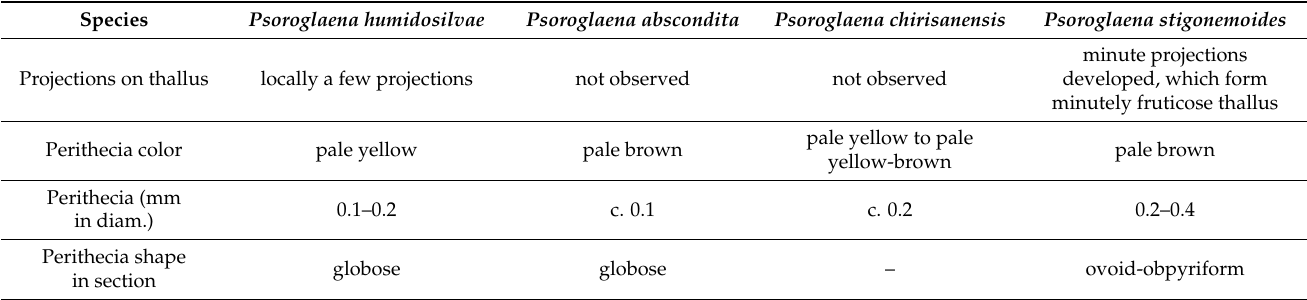
Table 2. Comparison of the new species with close species in the genus Psoroglaena